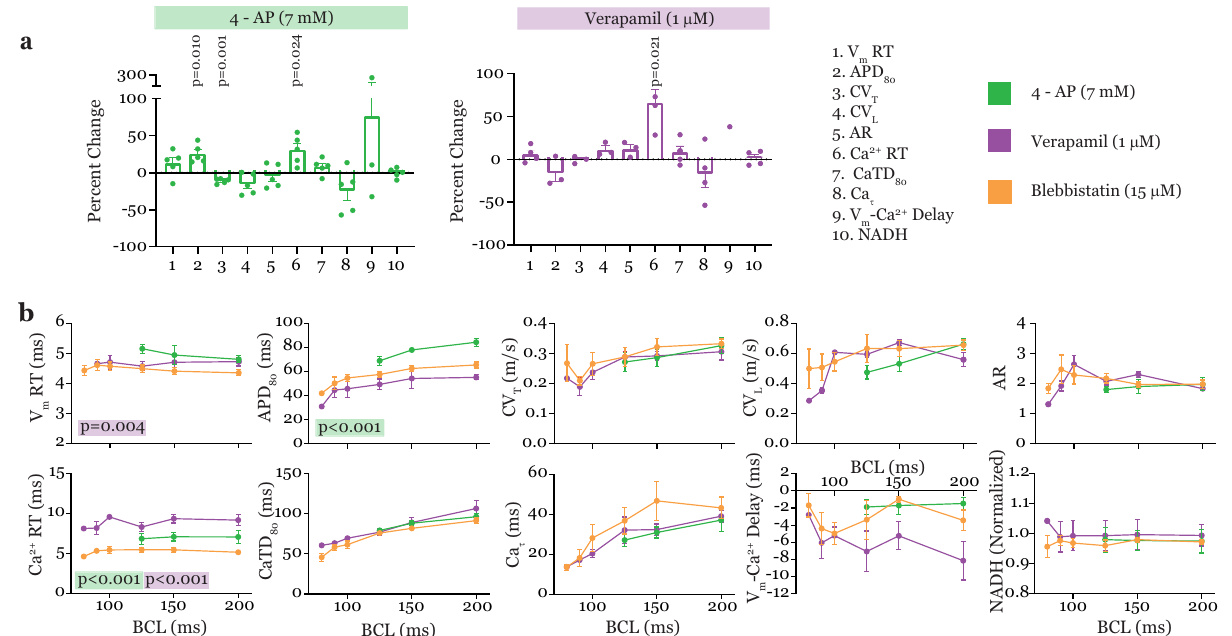
Fig. 3 Triple-parametric optical mapping in drug testing. a Ten-parameter panels demonstrating effects of 4-AP (7 mM, left, green) and Verapamil (1 μ M, right, purple). b Summary restitution properties of the ten parameters measured simultaneously by triple-parametric optical mapping. Data presented as mean ± s.e.m., n = 5 hearts. Least squares regression analysis was performed for data in panel ( b ) to detect signi fi cant differences in parameters during Blebbistatin versus drugs (4-AP, Verapamil) treatment and all signi fi cant p values are reported. Two-tailed, paired t -tests were performed for data in panel ( a ) to detect signi fi cant change induced by drugs compared to Blebbistatin and all signi fi cant p values are reported. Benjamini – Hochberg correction was applied to account for multiple